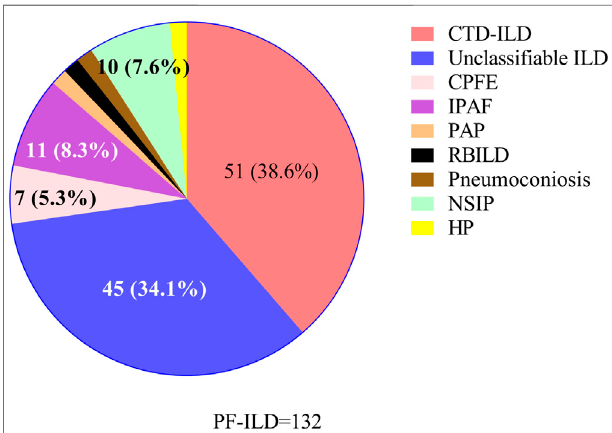
FIGURE 2 | Classi fi cations of PF-ILD in this study; Abbreviations: PF- ILD, progressive fi brosing interstitial lung disease; CTD-ILD, connective tissue disease-associated interstitial lung disease; CPFE, combined pulmonary fi brosis and emphysema; IPAF, interstitial pneumonia with autoimmune features; PAP, pulmonary alveolar proteinosis; RBILD, respiratory bronchiolitis-associated interstitial lung disease; NSIP, nonspeci fi c interstitial pneumonia; HP, Hypersensitivity pneumonitis. Number of cases: CTD-ILD (cid:1) 51, Unclassi fi able ILD (cid:1) 45, IPAF (cid:1) 11, NSIP (cid:1) 10, CPFE (cid:1) 7, PAP (cid:1) 2, RBILD (cid:1) 2, Pneumoconiosis (cid:1) 2, HP (cid:1) 2.